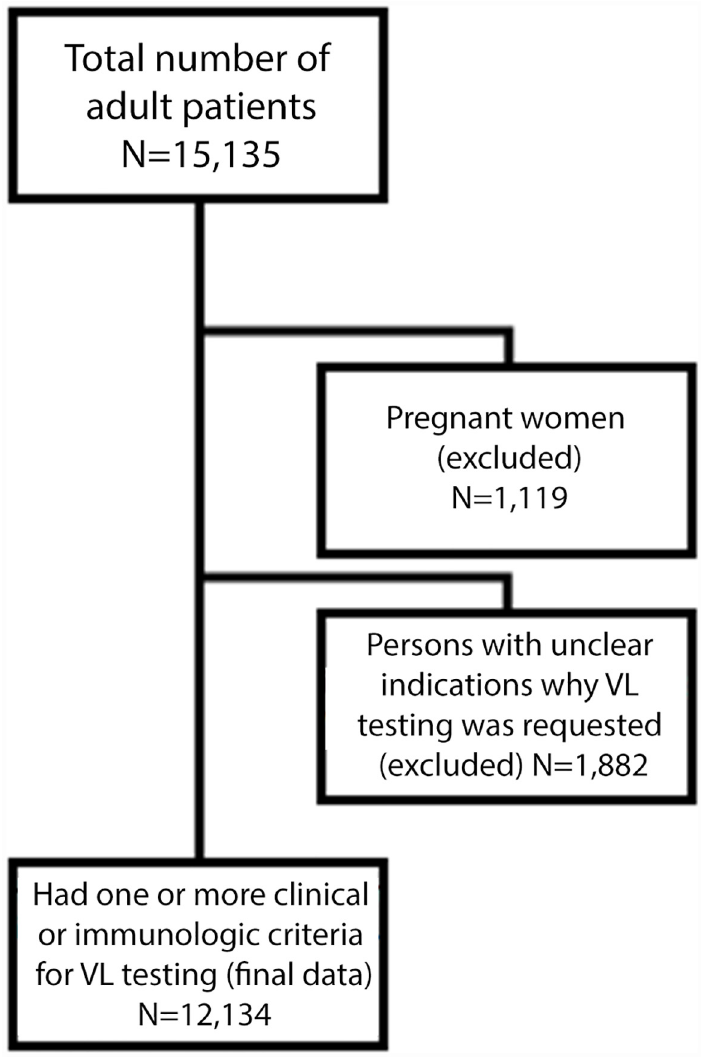
Fig 1. Inclusion of study subjects with clinical or immunological indication for viral load testing for analysis. This figure describes how the subjects were excluded from this analysis. We excluded 1,119 pregnant women and 1,882 persons with unclear indications why VL testing was requested.